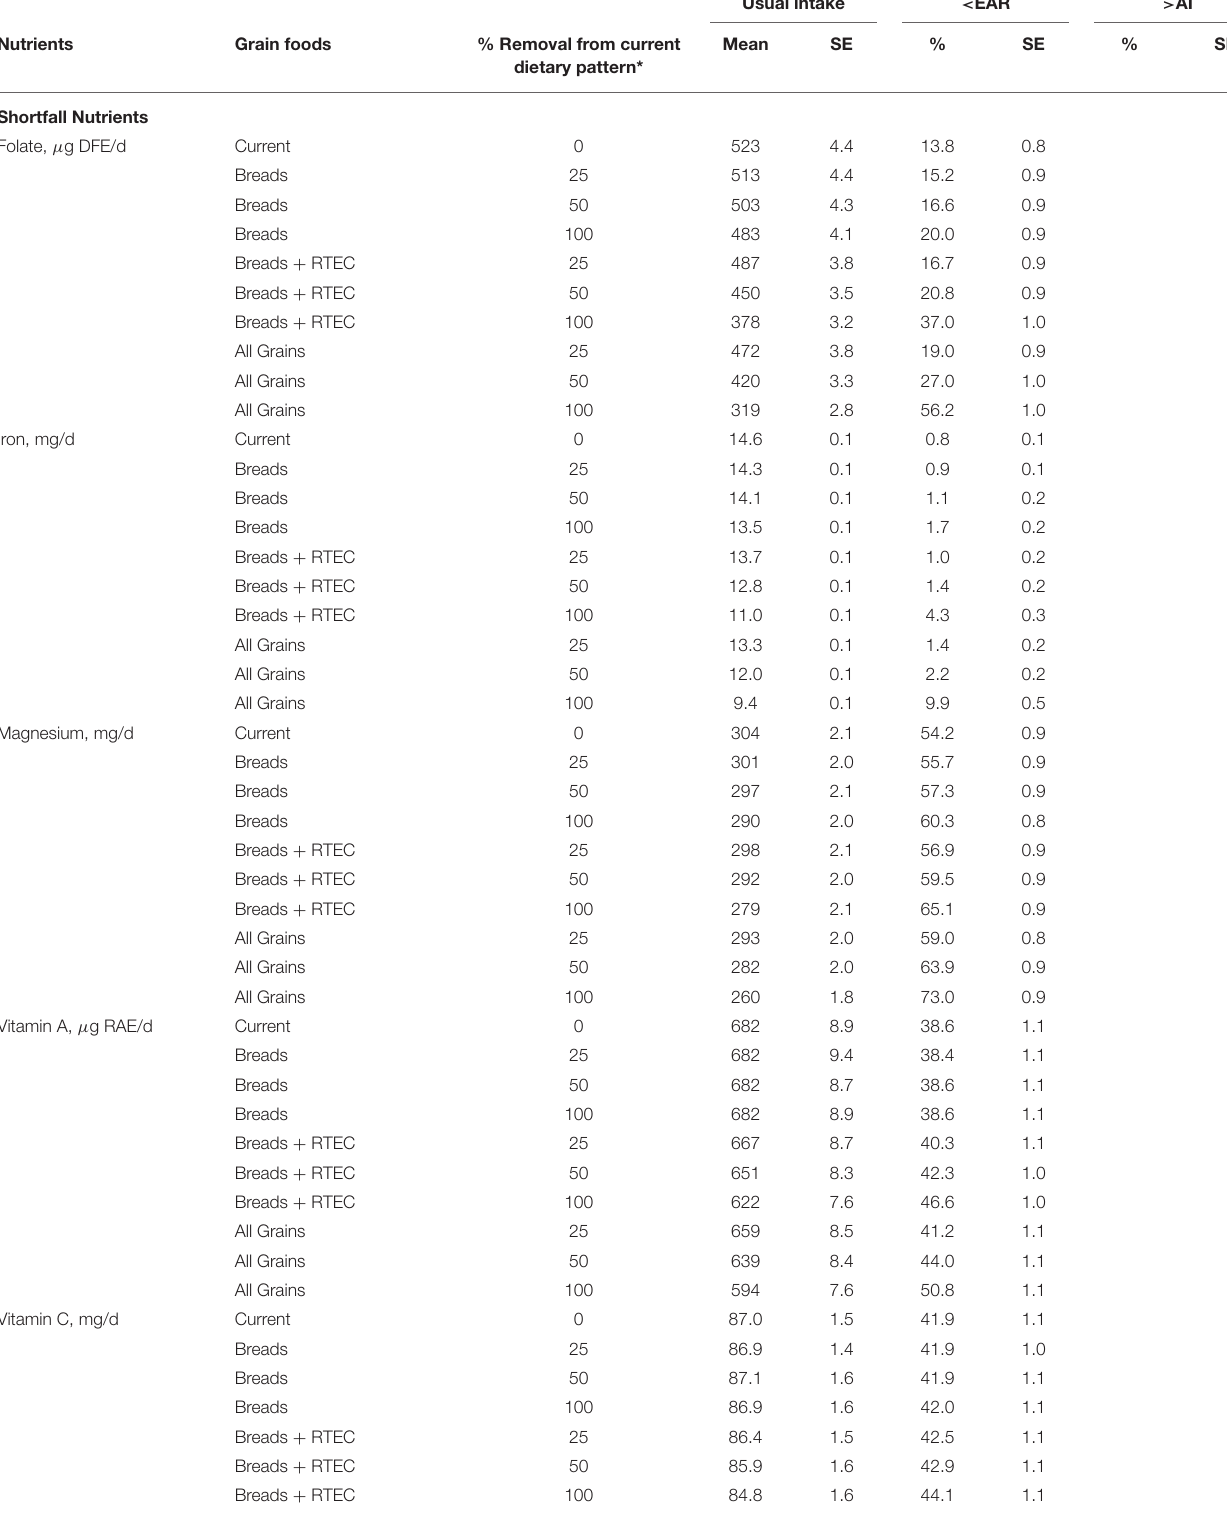
Usual intake < EAR > AI